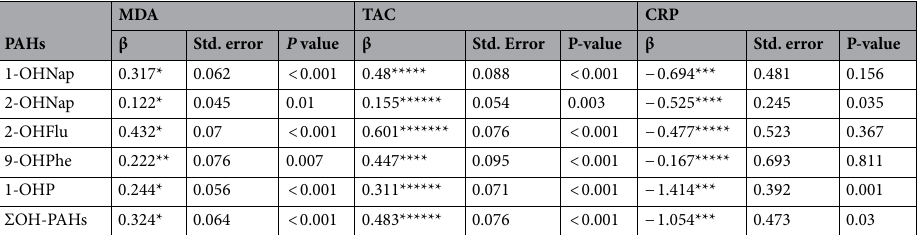
Table 2. The log transformed regression of PAH metabolites (ng/g cr) and MDA level (mM/mM cr), TAC (mM/mM cr), and CRP (mg/L) in the participants. * Adjusted for group, age, and type of used oil. ** Adjusted for group, age, type of used oil, use of hood, and second-hand smoke. *** Adjusted for group, use of hood, and second-hand smoke. **** Adjusted for group. ***** Adjusted for group and second-hand smoke. ****** Adjusted for group and age. ******* Adjusted for group, sex, and use of hood.